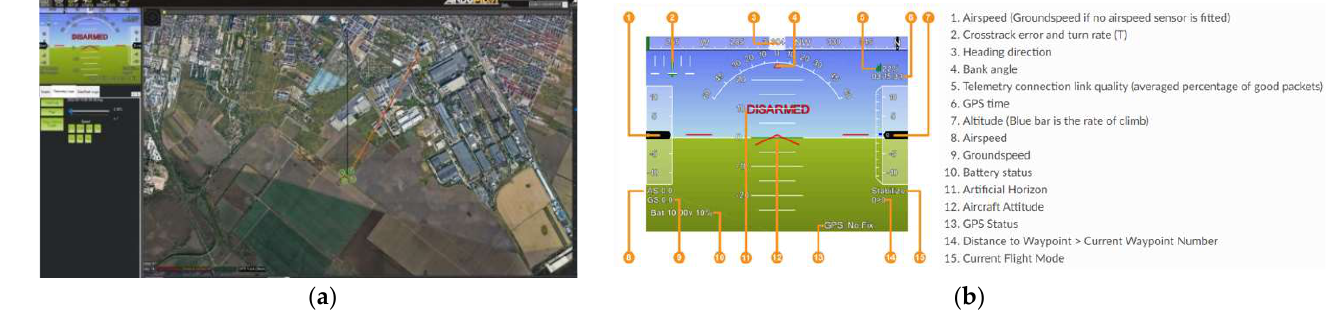
Figure 18. Mission planner ground control station. ( a ) Main window; ( b ) HUD window.